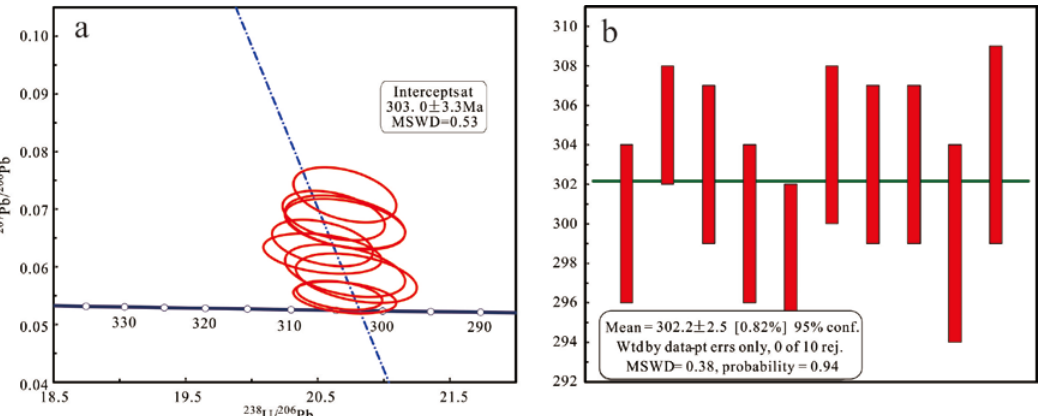
Figure 5. ( a ) Zircon concordia diagram for granodiorite samples from Tonggou deposit; ( b ) weighting diagram for granodiorite samples from Tonggou deposit.